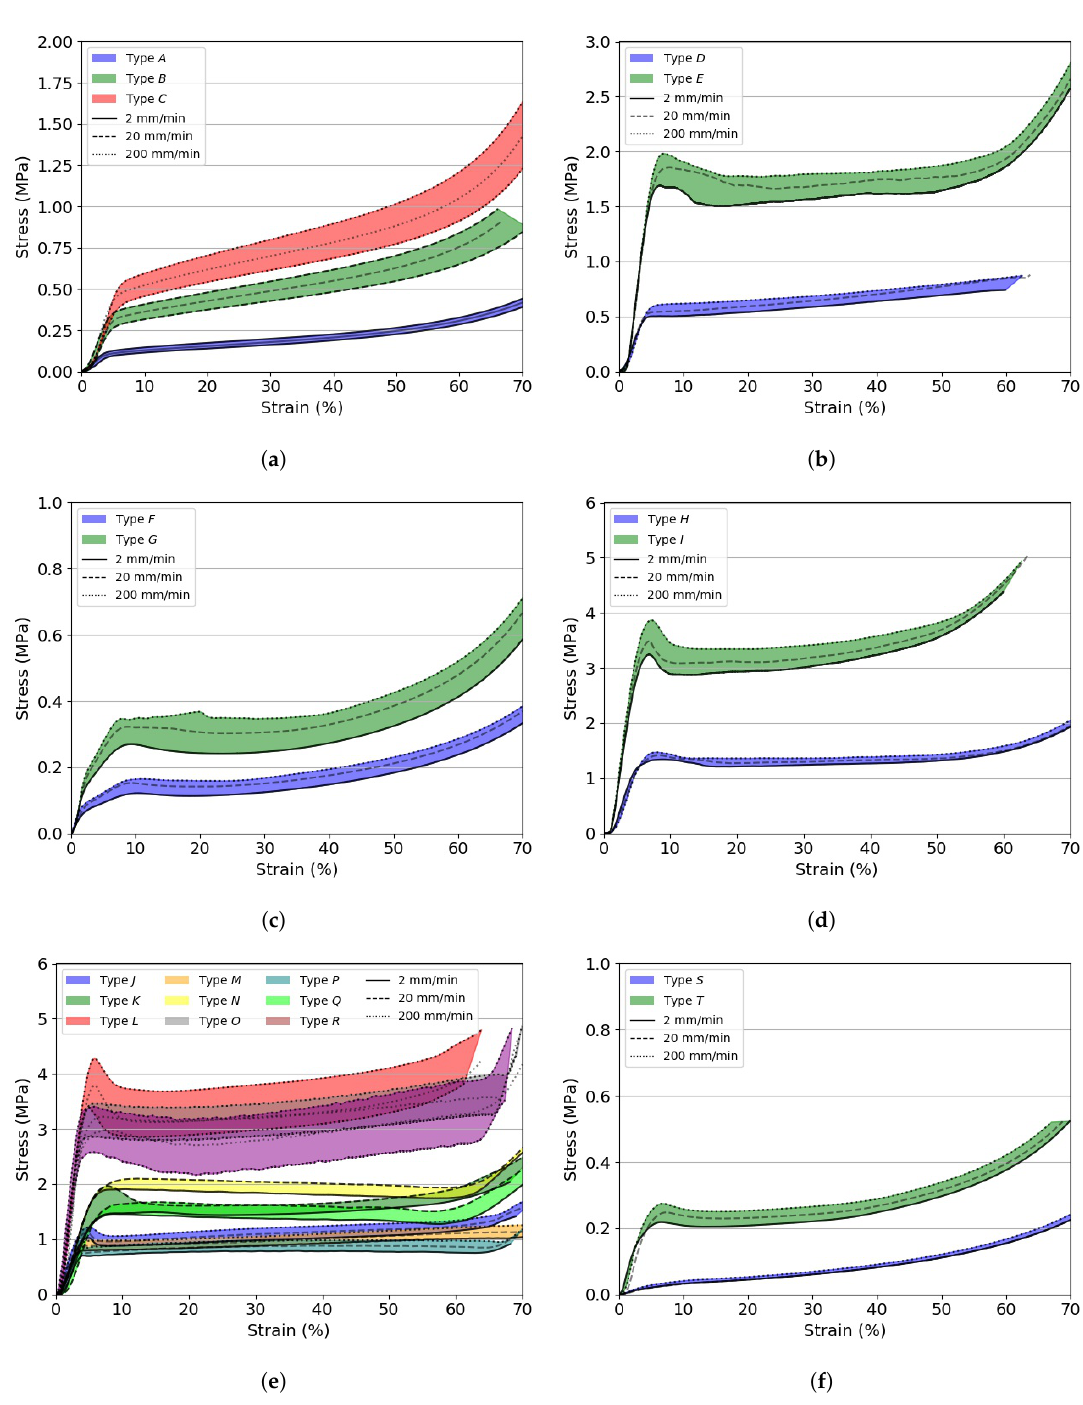
Figure 4. Compressive stress vs. strain curves for the investigated foams tested at different cross-head displacement rates. ( a ) EPP foams; ( b ) EPS foams; ( c ) PE foams; ( d ) PET foams; ( e ) PMI foams; ( f ) PVDF